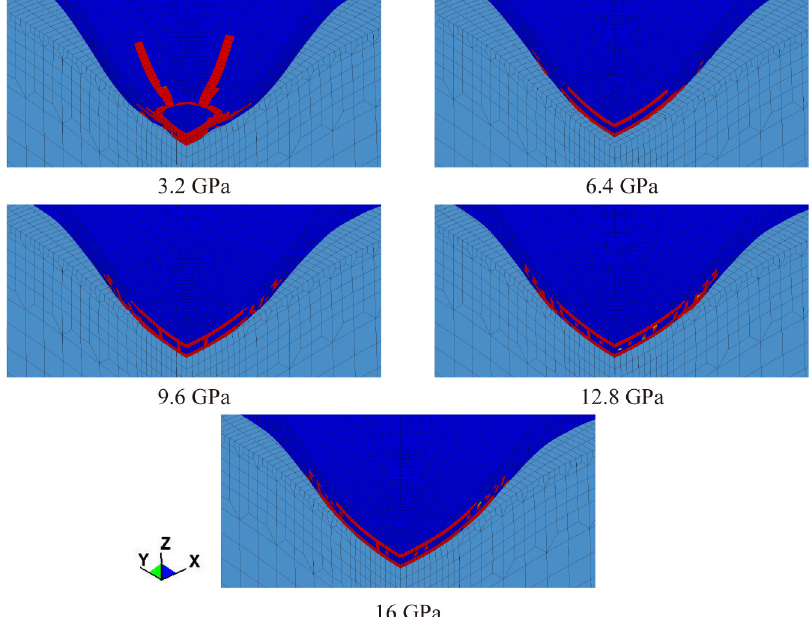
Figure 16. Final failure patterns of automotive coatings with different Young’s moduli of primer.